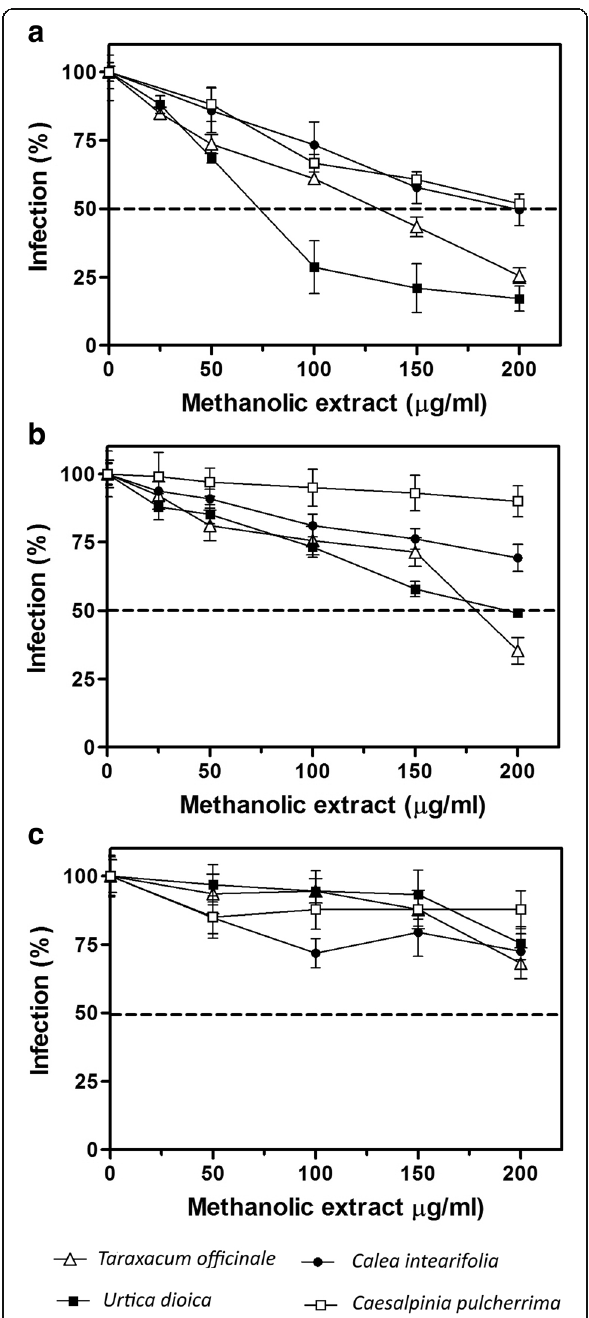
Fig. 1 Effect of methanolic plant extracts on the DENV replication in cell culture. Methanolic extracts at 60 ( a ), 85 ( b ) and 120 °C ( c ) of U. dioica , T. officinale , C. integrifolia and C. pulcherrima were tested in order to inhibit the replication in vitro of